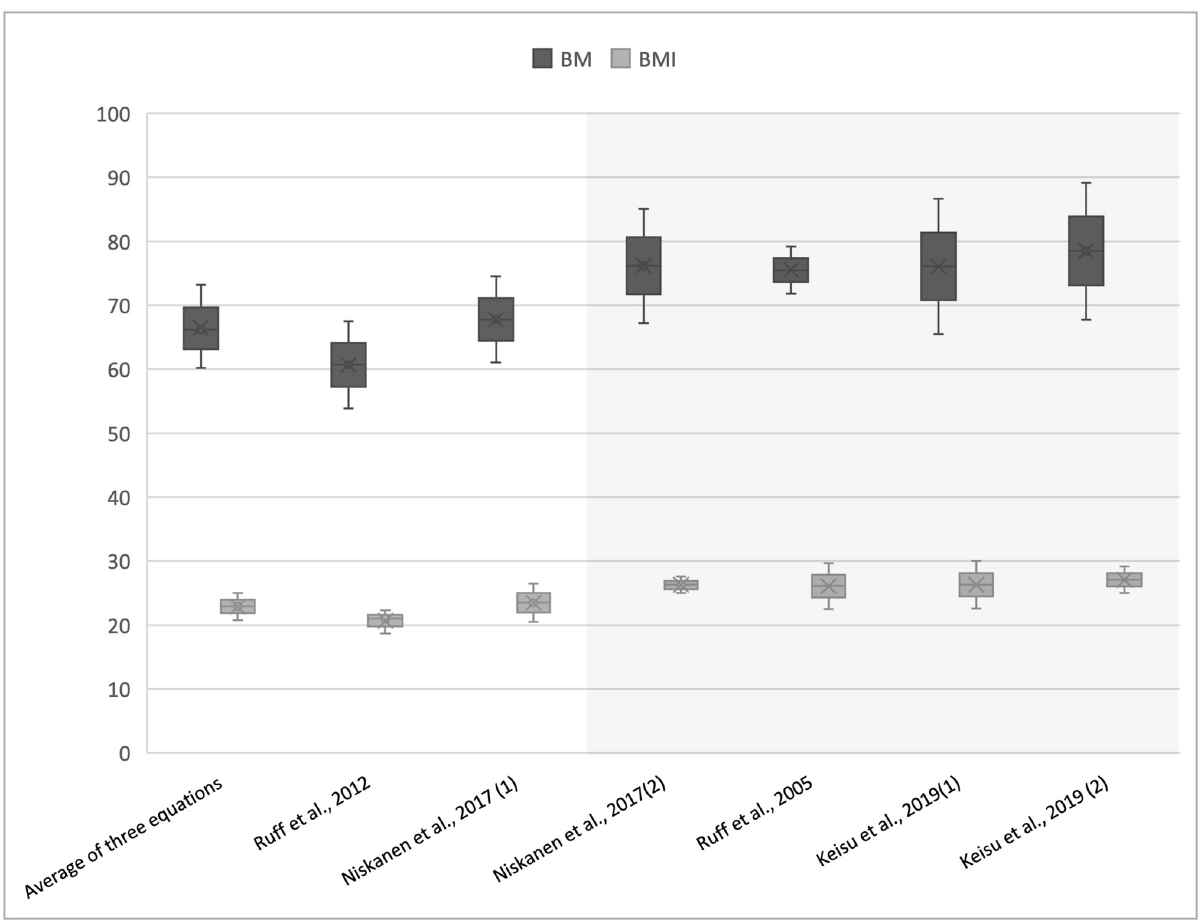
Fig 2. Body mass and body mass index of St Anthony yielded with different regression equations. In the grey box the peak of BM and BMI calculated using knee joint size and ST/BIB equations.